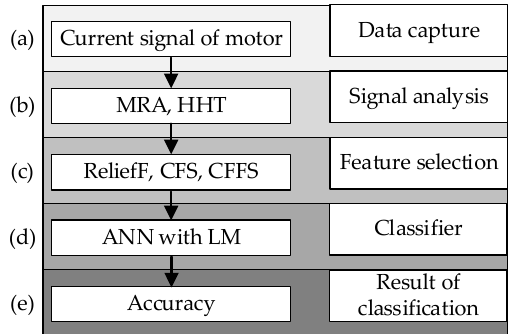
Figure 3. Schematic diagram of classification system. ( a ) capture the observations, ( b ) build fault detection dataset, ( c ) feature selection, ( d ) train the ANN, ( e ) classification result.